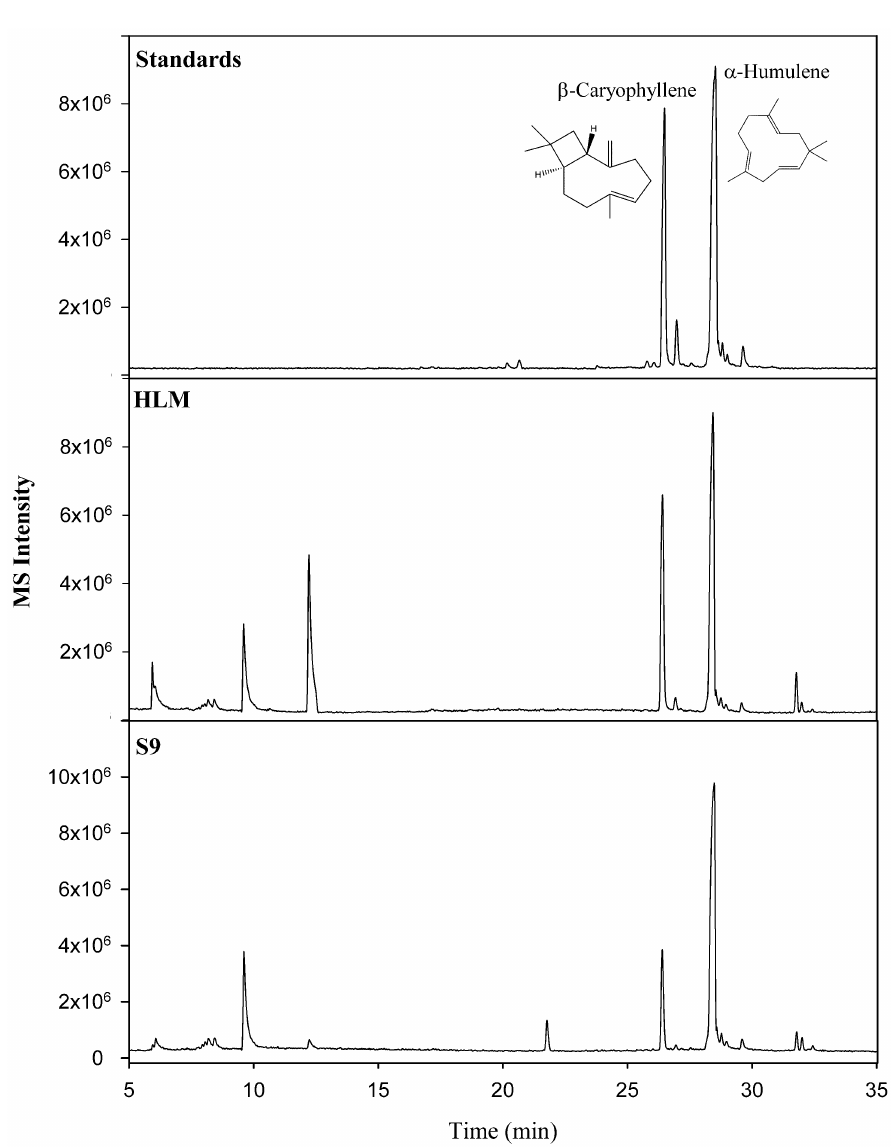
Figure 2. Comparison of representative total ion chromatograms of the chemical standards, human liver microsome (HLM), and S9 liver fractions.